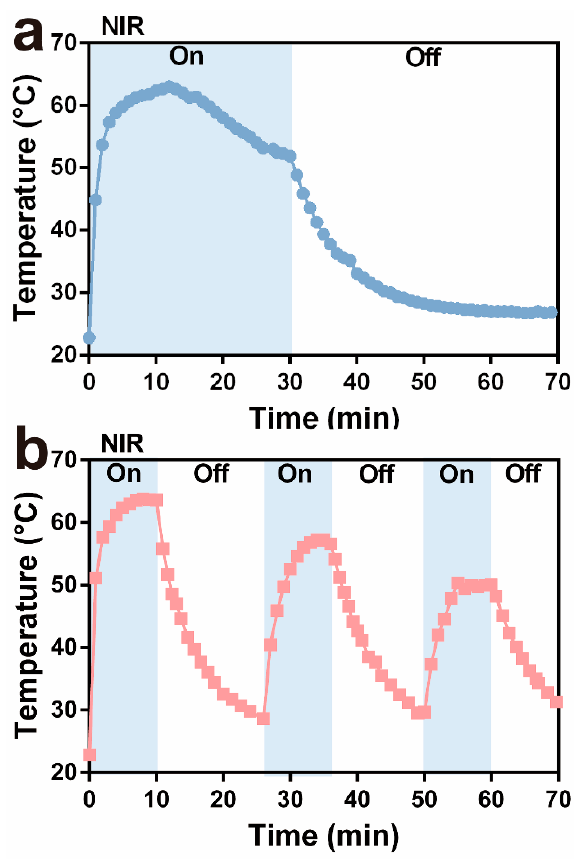
Figure 3. Change in thermal curves of ZIF-8-ICG suspensions after ( a ) one time irradiation and ( b ) three times irradiation for 30 min.